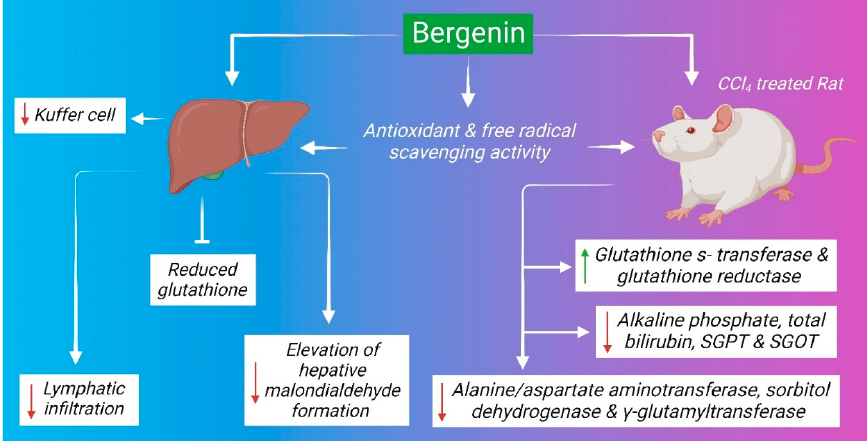
Figure 7. Hepatoprotective mechanism of B. ligulata . The plant extract shows hepatoprotective prop- erties through antioxidant activity and free radical scavenging activity. Bioactive compounds re- duce the number of Kuffer cells in the liver and inhibit the infiltration of lymphocytes. It also reduces alkaline phosphate, total bilirubin, serum glutamic-pyruvic transaminase (SGPT) and serum glu- matic-oxaloacetic transaminase (SGOT), alanine aminotransferase (ALT), sorbitol dehydrogenase, and γ -glutamyl transferase. Further, it helped resist the depletion of reduced glutathione content and inhibit malondialdehyde formation in the liver of CCl 4 -treated rats. inhibit malondialdehyde formation in the liver of CCl 4 -treated